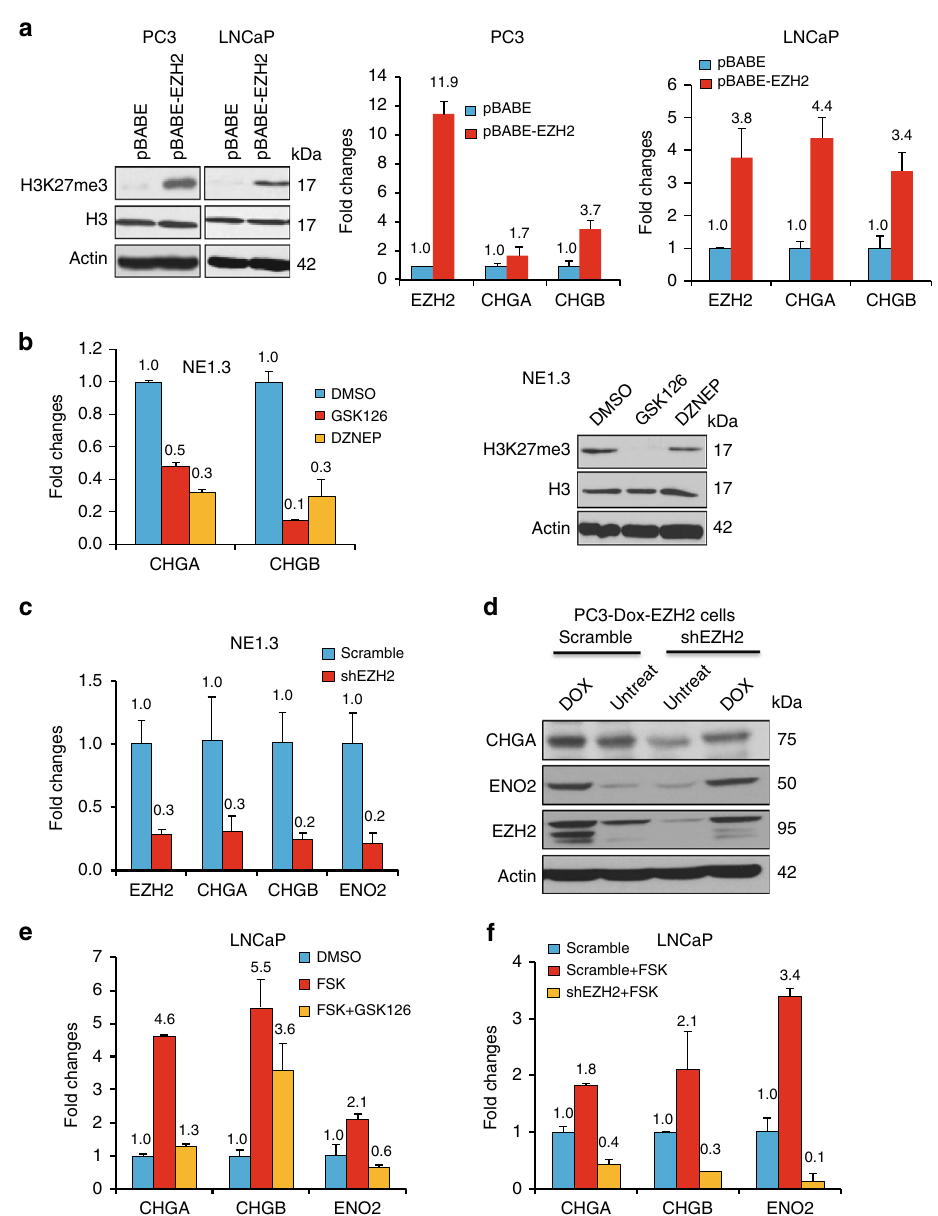
Fig. 4 EZH2 is a critical for CREB to induce NE phenotypes. a H3K27me3 level (left), as well as expression of EZH2 and NE markers (right), are up- regulated in PC3 and LNCaP cells overexpressing EZH2 cDNA. b RT-qPCR measures the expression of NE markers CHGA, CHGB in NE1.3 cells treated with EZH2 inhibitors GSK126 (5 μ M) or DZNEP (5 μ M) for 48 h (left). Western blotting con fi rmed the reduction of H3K27me3 in NE1.3 cells treated with these EZH2 inhibitors (right). Error bars in PCR results represent standard deviation (s.d.) of triplicate experiments. c RT-qPCR result shows that EZH2 knockdown by a validated shRNA downregulates the expression of NE markers CHGA and CHGB in NE1.3 cells. d PC3 cells carrying Dox-inducible EZH2 cDNA were infected with scramble shRNA or shEZH2 lentiviruses, then treated without or with 1 μ g ml − 1 of Dox for 72 h. e RT-qPCR analysis of the changes in NE marker expression in LNCaP cells after treating with 10 μ M forskolin (FSK) with or without 5 μ M EZH2 inhibitor GSK126 for 24 h. f LNCaP cells expressing either control shRNA or shEZH2 were treated with 10 μ M FSK for 5 h. CHGA, CHGB, and ENO2 levels were measured by RT-qPCR, using GAPDH as the loading TSP1 expression negatively correlates with EZH2 and NE markers . Further supporting the existing of an EZH2/TSP1 axis in human prostate cancers, we found that TSP1 and EZH2 are expressed signi fi cantly lower and higher, respectively, in meta- static CRPC than in localized prostate cancers (Grass- o_mCRPC 39 ) (Fig. 6a). Similarly, in the Beltran_NEPC dataset 6 , TSP1 expression is lower, while EZH2 expression is higher, in NEPC than in CRPC-adenocarcinoma (Fig. 6b). As expected, NE markers are upregulated in metastatic tumors vs localized tumors,